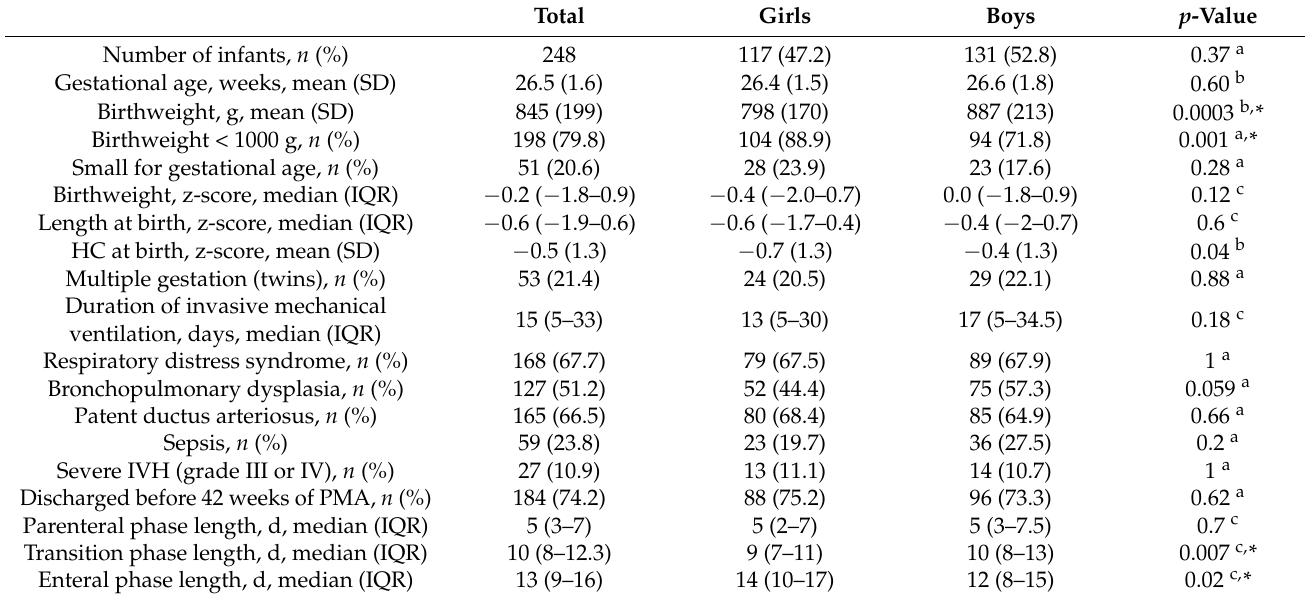
Table 1. Clinical characteristics of the study